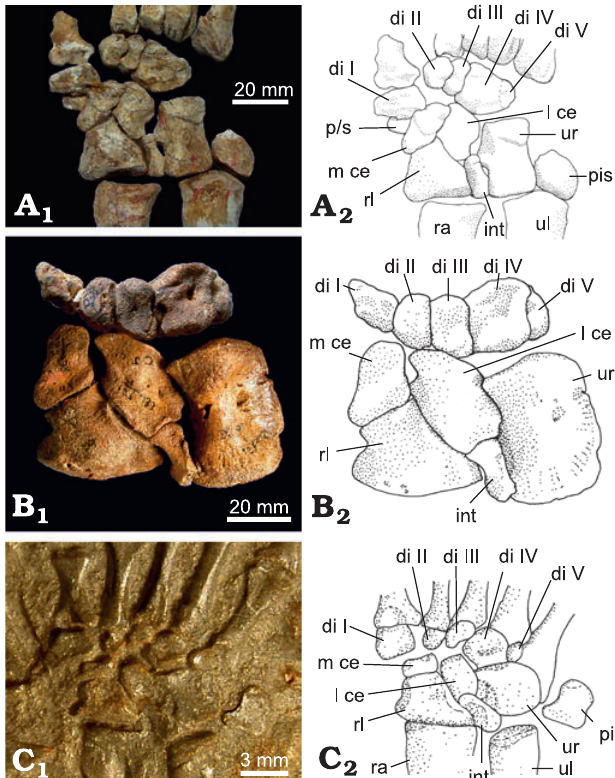
Fig. 4. Carpus of basal Therapsida. A . A biarmosuchian PIN 1758/320, Eshovo, Russia, Roadian, Guadalupian, right carpus, slightly disarticula- ted, dorsal view. B . Dinocephalian Titanophoneus potens Efremov, 1940, PIN 157/1, Isheevo, Russia, Capitanian, left carpus (reversed), dorsal view. C . Basal anomodontian Galechirus scholtzi Broom, 1907, SAM-PK-1068, Victoria West, South Africa, Capitanian, right carpus, dorsal view (im- pression). Photographs (A 1 –C 1 ) and interpretative drawings (A 2 –C 2 ). Abbreviations: di, distal carpal; int, intermedium; l ce, lateral centrale; m ce, medial centrale; pis, pisiform; p/s, prepollex/sesamoid; ra, radius; rl, radiale; ul, ulna; ur, ulnare. to us where the intermedium is longer than the radiale (SOM: table 2: e). The non-mammaliamorph therapsid intermedium is lateromedially narrow and dorsoventrally deep. It is a prox- imodistally oriented, rectangular to hourglass-shaped slender bone (Figs. 4A–8A), or bean-shaped in Kannemeyeria and Galesaurus BP/1/2513 (Fig. 7C; SOM: table 2: a). Proxi mally, the intermedium articulates with the ulna (SOM: table 2: b). Distally it contacts the lateral centrale (SOM: table 2: c). Laterally, it is articulated with the ulnare and medially with the radiale and/or the lateral side of the distal end of the radius (SOM: table 2: d). In a few cases, it only contacts the radiale medially (Biarmosuchidea indet. PIN 1758/320, Fig. 4A, Estemmenosuchus , Stahleckeria , Glanosuchus SAM- PK-12051 and CGS RS424, Theriognathus and Ictido­ suchoides CGS CM86-655, Fig. 6D). In Caseidae (Fig. 3A, B) and some single specimens of other groups ( Edapho saurus , Procynosuchus RC92, Fig. 7A, Exaeretodon , and probably Ciste cephalus ), the intermedium is situated even further proximally than in the other synapsids and lies laterally to the radius (SOM: table 2: d).